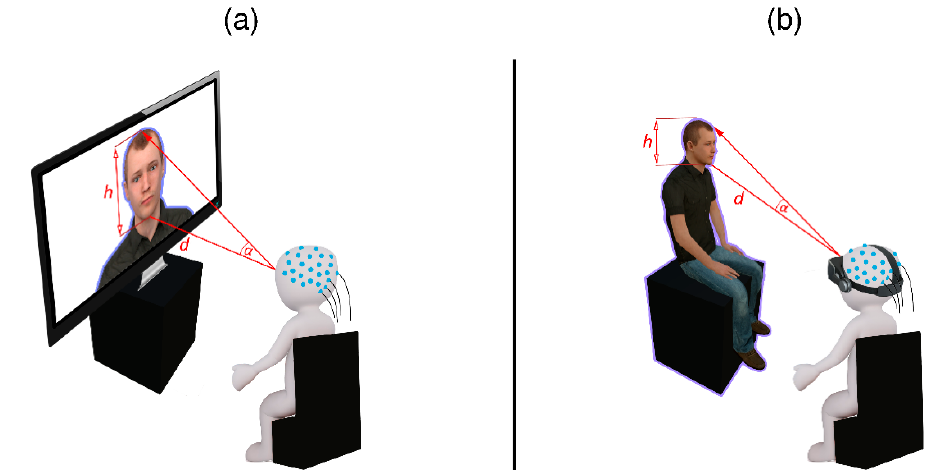
Figure 3. Illustrative setup of the two conditions 2D ( a ) and VR ( b ). The participants sat in a chair. Stimuli were displayed on a monitor screen (2D), or in Virtual Reality (VR). Stimulus size, distance and viewing angle for the face were controlled for in both conditions (h = 25 cm, d = 110 cm, α = 13°).